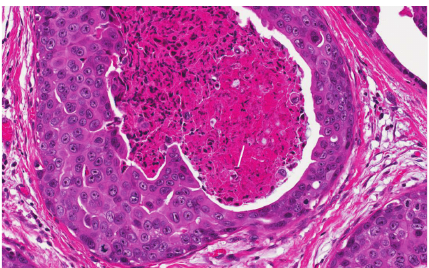
Figure 3: High-grade DCIS with central comedo-type necrosis.